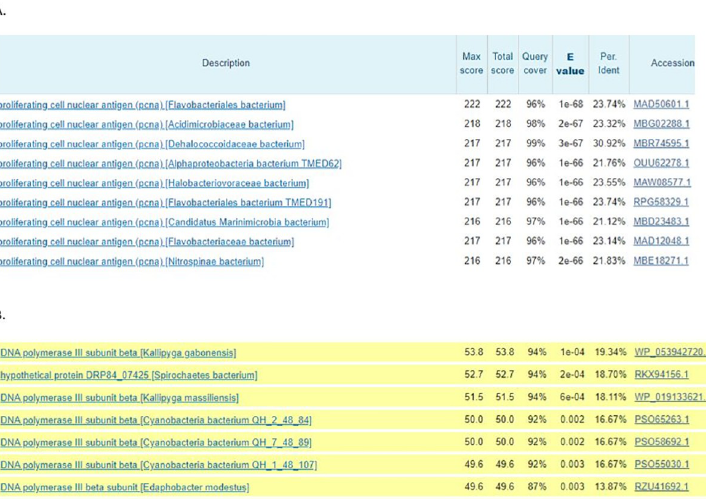
Fig 1. Screenshot of the results obtained when P. furiosus PCNA is PSI blasted against the NCBI bacterial database. (A) shows the results obtained when regular blast is carried out. PCNA sequences in undefined bacterial genomes appear. It is possible that these bacterial PCNAs emerged in the bacterial genome from horizontal gene transfer from archaea and eukarya. (B) shows bacterial beta clamp from some defined and some undefined species that appear in the blast after the second iteration. The yellow color represents hits that only appear in the second iteration of the blast. Kallipyga gabonensis is the top defined beta clamp hit in the bacteria. Other defined bacterial beta clamps that appear in the blast search are Kallipyga massiliensis and Edaphobacter modestus beta clamps. Query cover above 90 percent in these searches indicates that the entire PCNA was covered during the blast search.